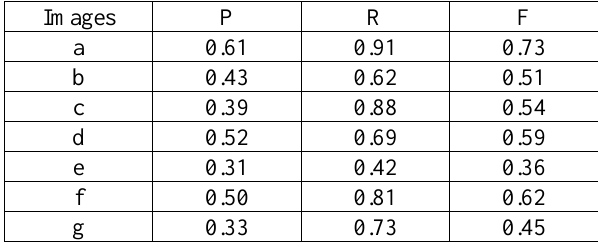
Table II . Quantitative precision and recall comparison between our method and human